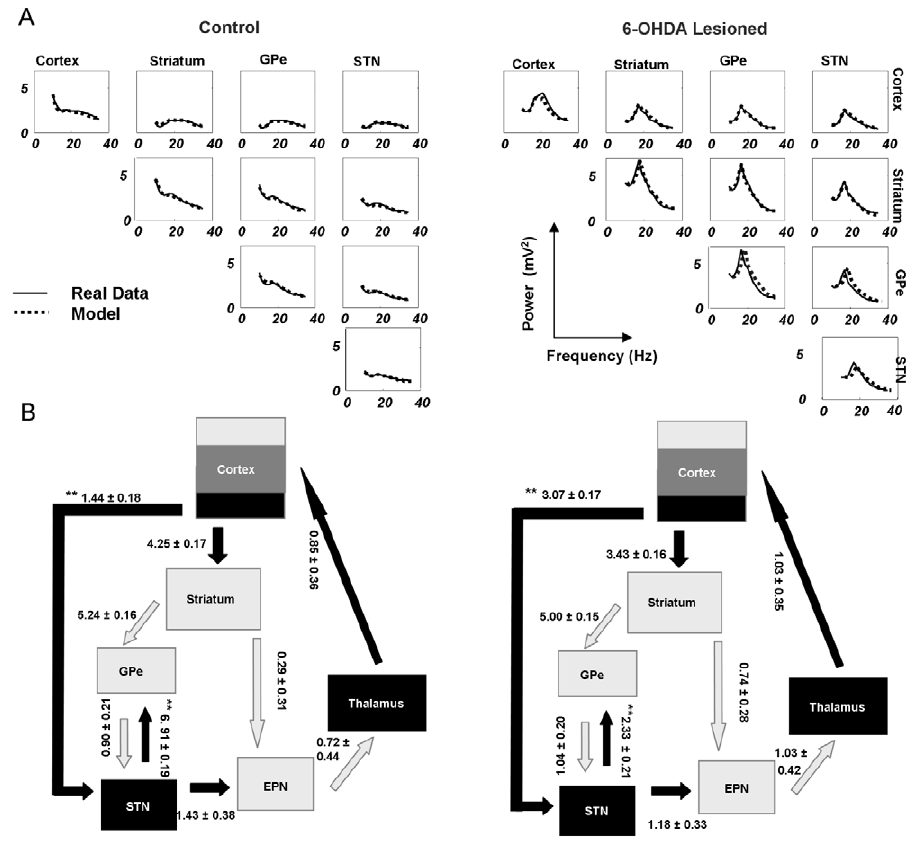
Figure 4. Model fits and posterior connectivity estimates. (A) Observed and modelled cross-spectral densities. Densities for frequencies from 10 Hz to 35 Hz were extracted from time domain data using a vector autoregressive model. Left Average LFP data (full lines) and average DCM fits (dashed lines) for control animals (n=8). The main diagonal displays the auto-spectral densities at each electrode and the off-diagonal elements display the two-way cross spectra. Right Average data and model fits in Parkinsonian animals (n=9). Note that only the Parkinsonian animal data and model fits have prominent beta-band peaks. (B) Posterior connectivity estimates from each individual animal’s DCM were combined to form group averages. Average MAP estimates are shown with 95% Bayesian credible intervals. Left Average connectivity estimates from the control animals. The strongest connectivity in this circuit is the excitatory connection from STN to GPe. Similarly strong connections exist for cortical connections to the striatum and for striatal connections to the GPe. Right Posterior estimates from the 6-OHDA-lesioned animals are also strong along the indirect pathway from striatum to GPe and at cortical efferents to striatum and STN. Differences in connectivity strengths between the control and Parkinsonian groups with a probability . 99.99%, are indicated**. Two key differences are observed. 1. the hyperdirect pathway is stronger in 6- OHDA-lesioned animals, and 2. STN input to GPe is weaker in lesioned animals.